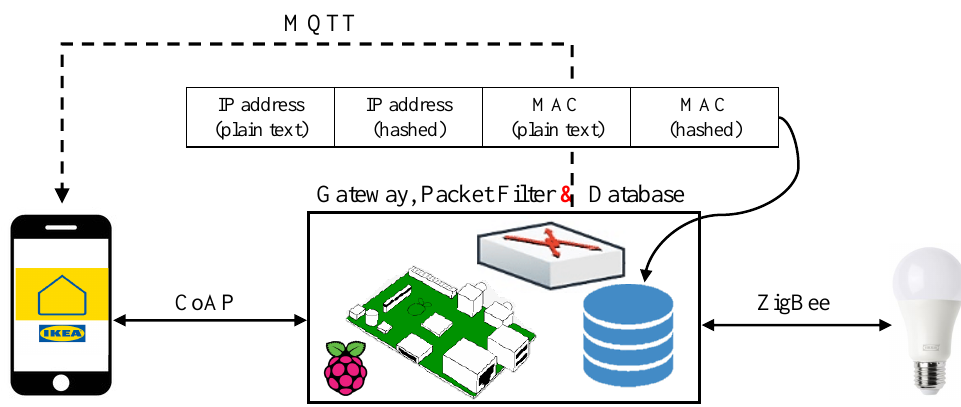
Figure 11. Authorized device registration through IP and MAC addresses. Illustrated is an MQTT broker containing a packet filter and a database of plain-text and hashed IP and MAC addresses to authenticate joining ZEDs.